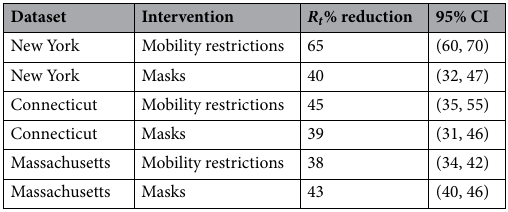
Table 3. Changes in R t due to each type of